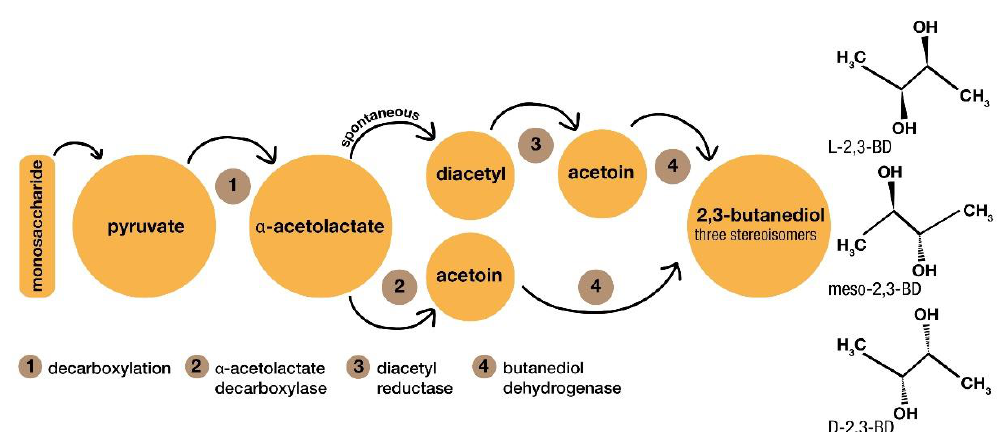
Figure 2. The synthesis steps leading to